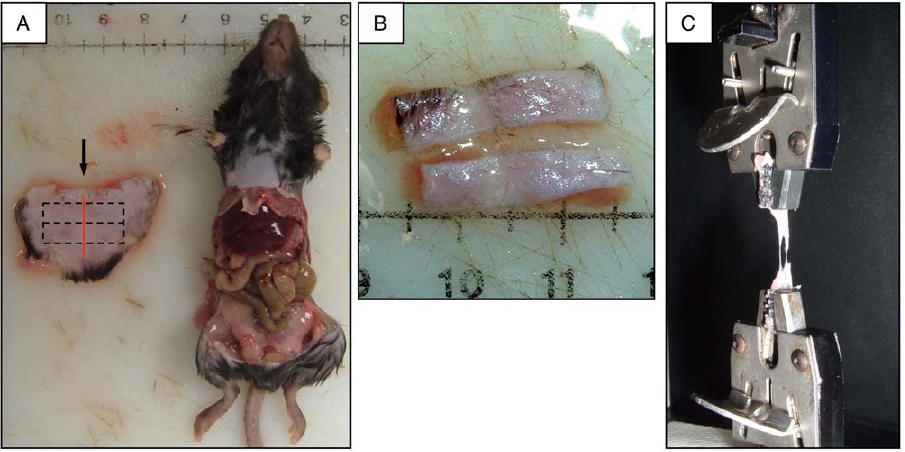
Figure 3. Wound disruption assay. (A) Ventral image of supine subject after harvest of ventral abdominal wall; note exposure of abdominal viscera. Excised specimen is shown to the left in its approximate anatomic position. Dashed lines demonstrate how test strips were cut from the specimen. Vertical red line shows location of vertical midline incision (scale=cm). (B) Test strips cut from abdominal wall specimen similar to that shown in panel A; orientation is same as that shown in panel A (scale=cm). (C) Disruption of a test strip in the tension tester. This specimen is nearly in two halves, connected by two fine strands of tissue.